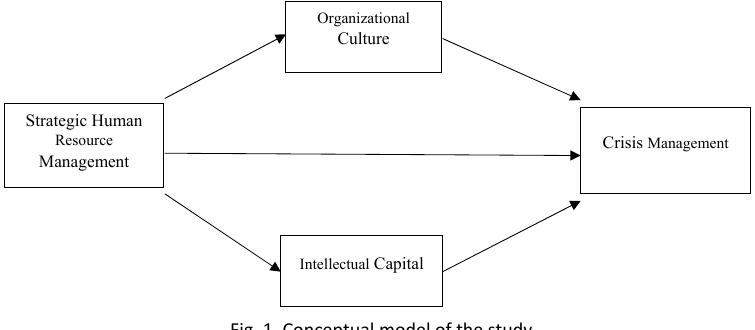
Fig. 1. Conceptual model of the study Fig. 1: Conceptual model of the